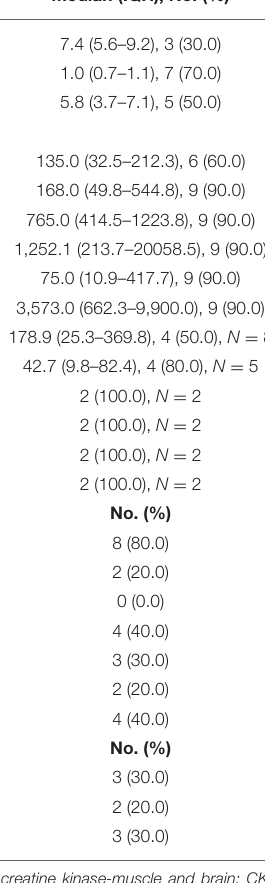
TABLE 2 | Laboratory tests and echocardiogram findings of the patients with cardiac irAE. Last lab test indexes before Steroids ( U ; normal range), change Median (IQR), No.